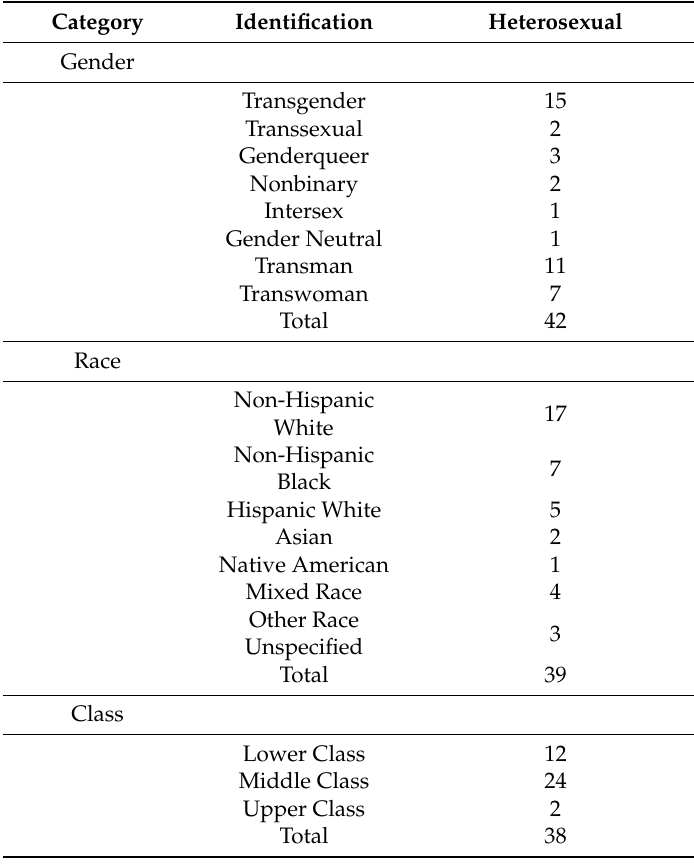
Table 2. Heterosexual sample